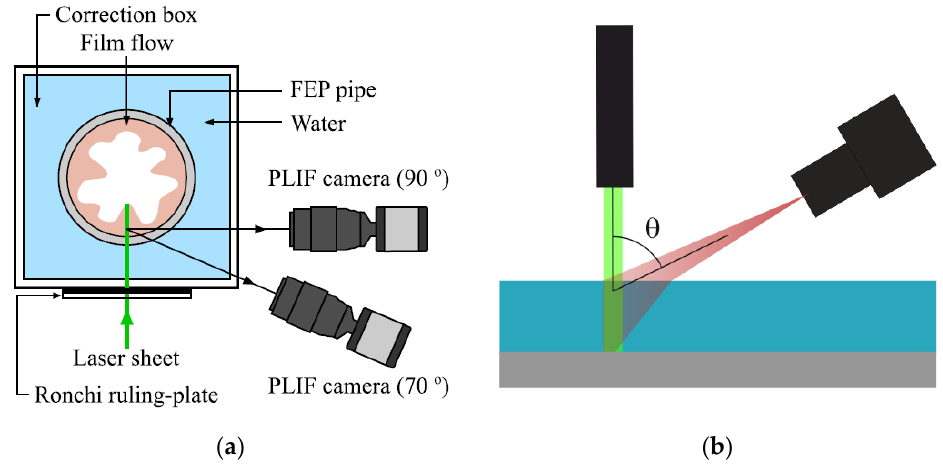
Figure 1. Layout of camera and laser in PLIF-method. ( a ) Annular gas ‒ liquid film in a circular FEP pipe (enclosed into an optical box) viewed through the pipe wall. Two cameras with 𝜃 of 70° and 90° to the laser sheet are shown [70]. ( b ) A sketch of typical layout of laser and camera studying a liquid film on a non-transparent flat plane through the interface. The fourth column specifies the angle 𝜃 between the laser sheet plane and the camera.